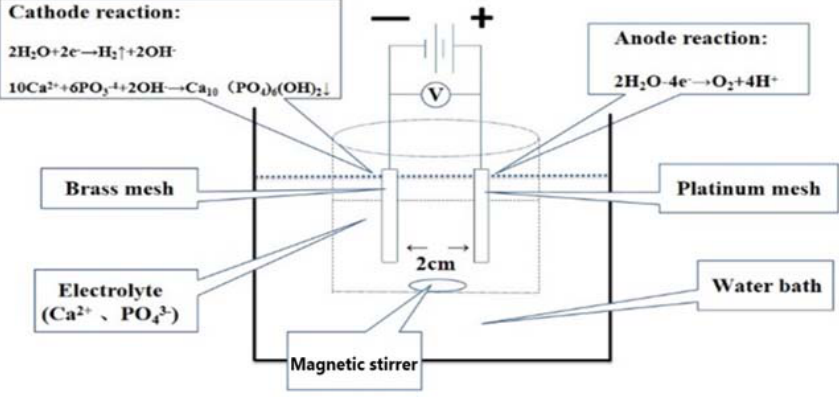
Figure 1. SEM characterization for the untreated ( A ), electrodeposited ( B ) and superhydrophobic brass mesh ( C ),